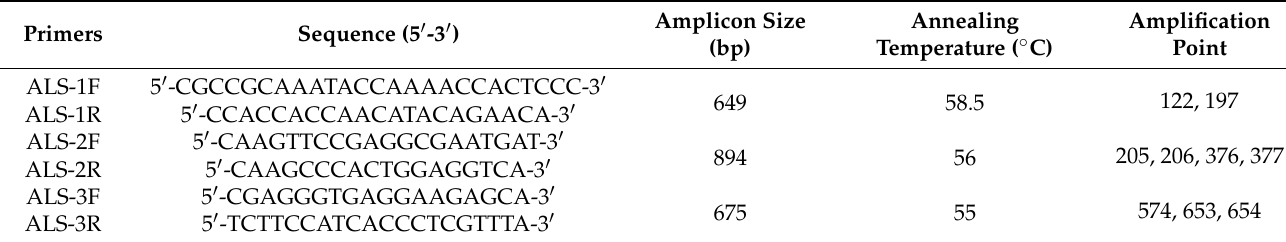
Table 5. Primers used in this